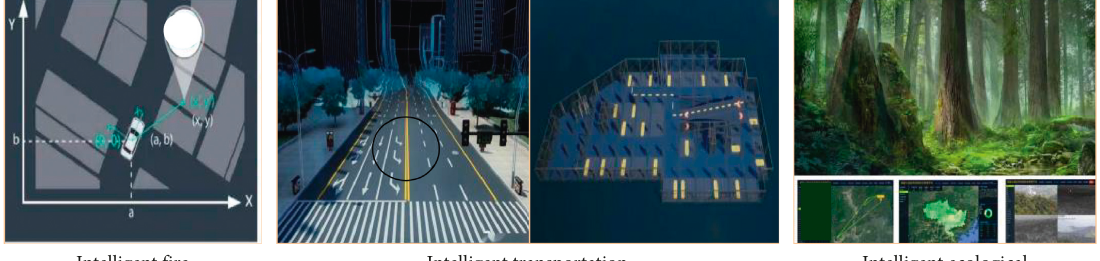
Figure 1: Smart city application